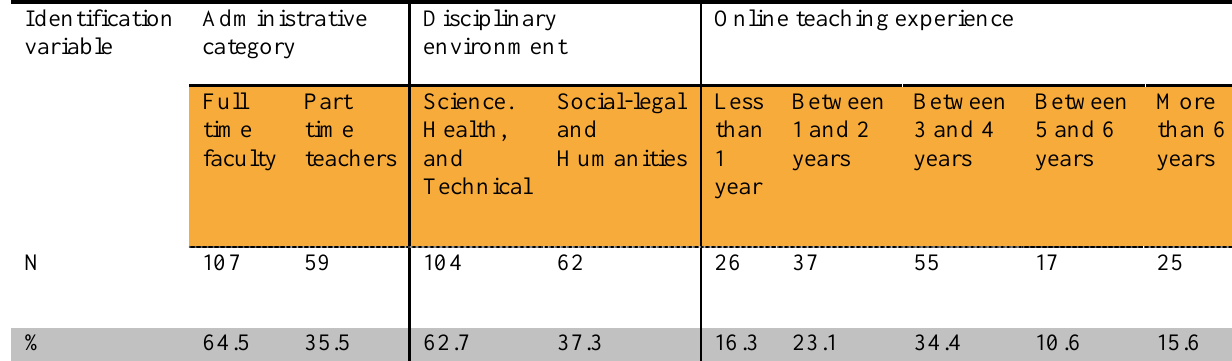
Characteristics of the Sample Population Arranged by Categories: Administrative, Scientific Environment, and Teaching Experience within Virtual Learning